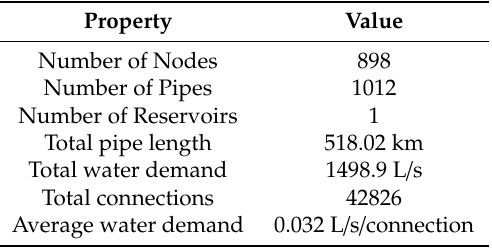
Table 2. Characteristics of H Table 2. C haracteristics of H town.